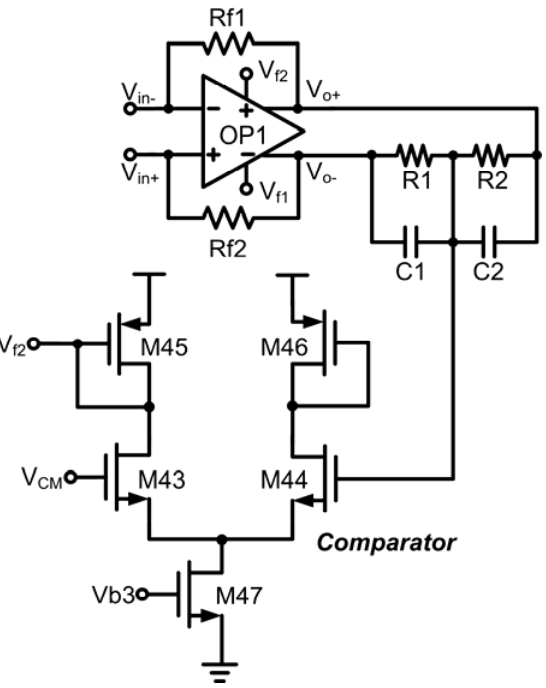
Figure 8. Common mode feedback circuit of the second